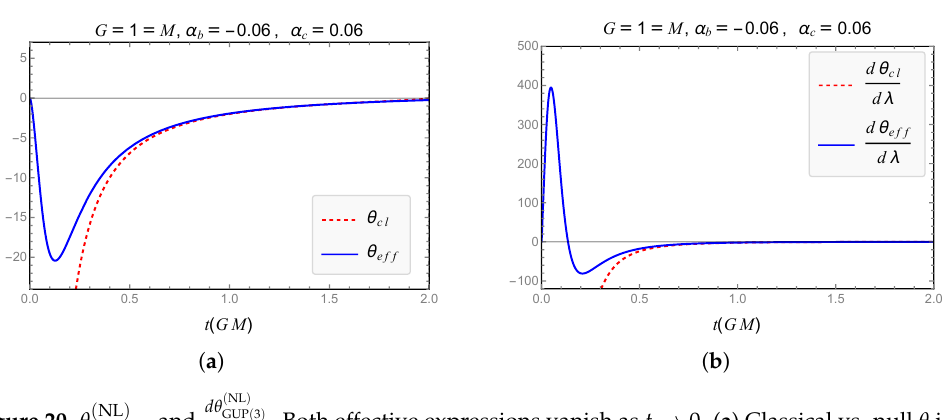
Given the behavior of the equations of motion and the signs of α b , α c , clearly the correction term up to the first order in α ’s in the negative branch of θ d θ ( NL ) GUP ( 3 ) same is true for similar terms in . As is expected the full expressions behave in a d λ d θ ( NL ) ( NL ) GUP ( 3 ) way that both θ and remain finite everywhere in the interior. This is shown d λ GUP ( 3 ) in Figure 20.